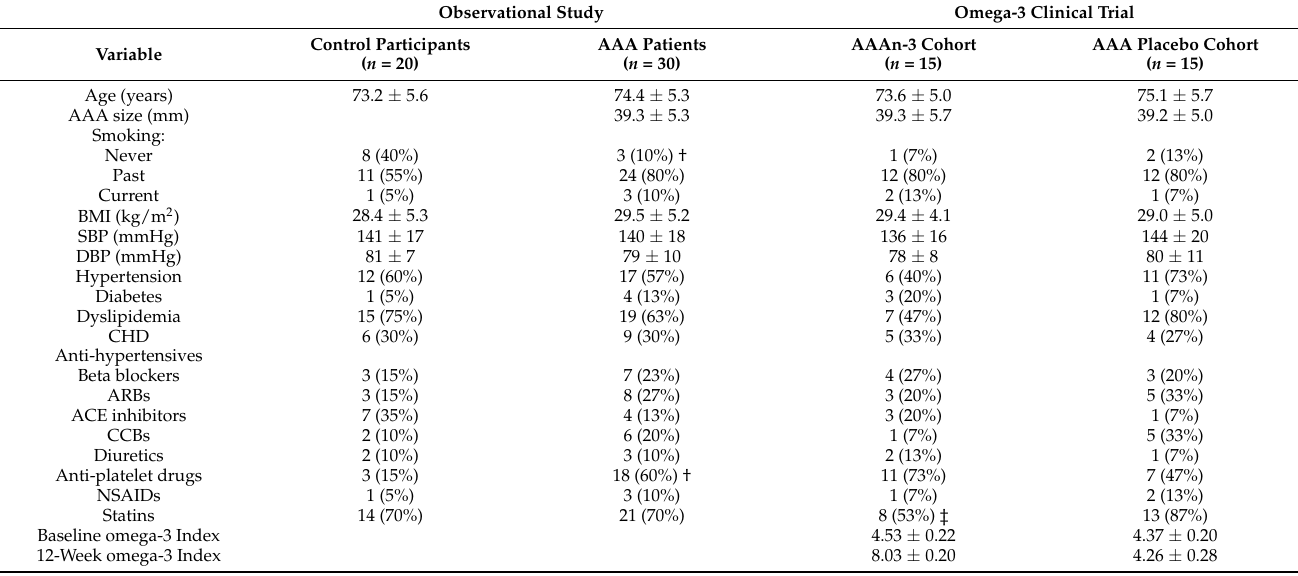
Table 1. Demographic, biometric and medical characteristics of male patients with abdominal aortic aneurysm (AAA) and control participants. Continuous demographic data are presented as mean ± SD, categorical demographic data are presented as number